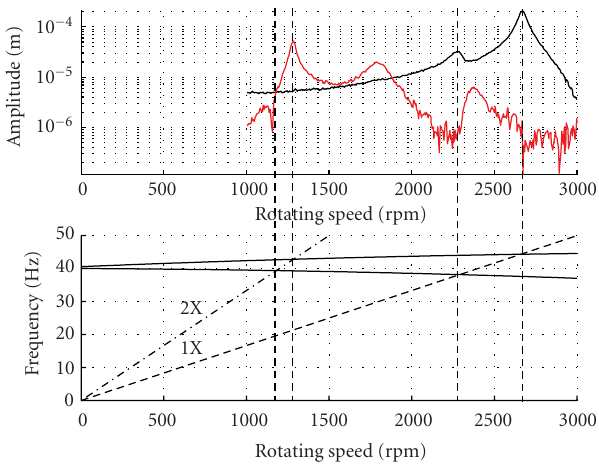
Figure 4: Unbalance response (black line = 1st order, red line = 2nd order) and Campbell diagram at the bearing support B1.